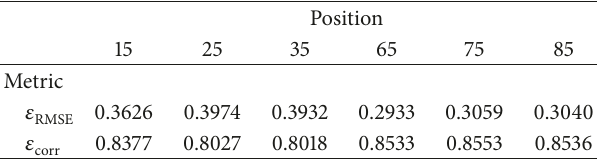
Table 3: Estimation error metric values versus link distance (m).